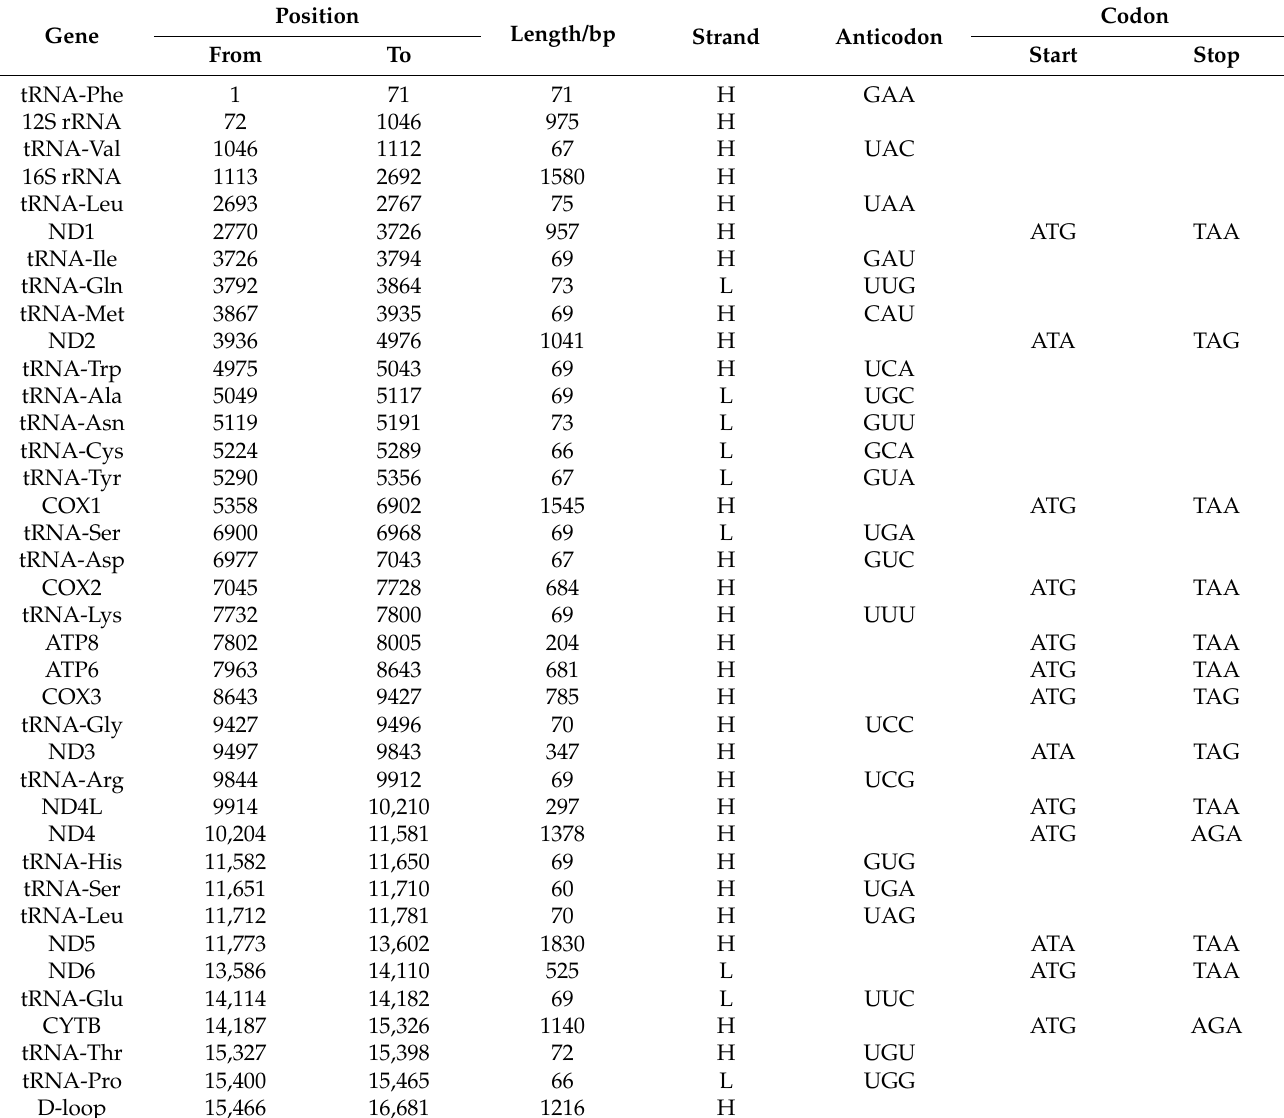
Table 1. Summary of the Huaibei grey donkey